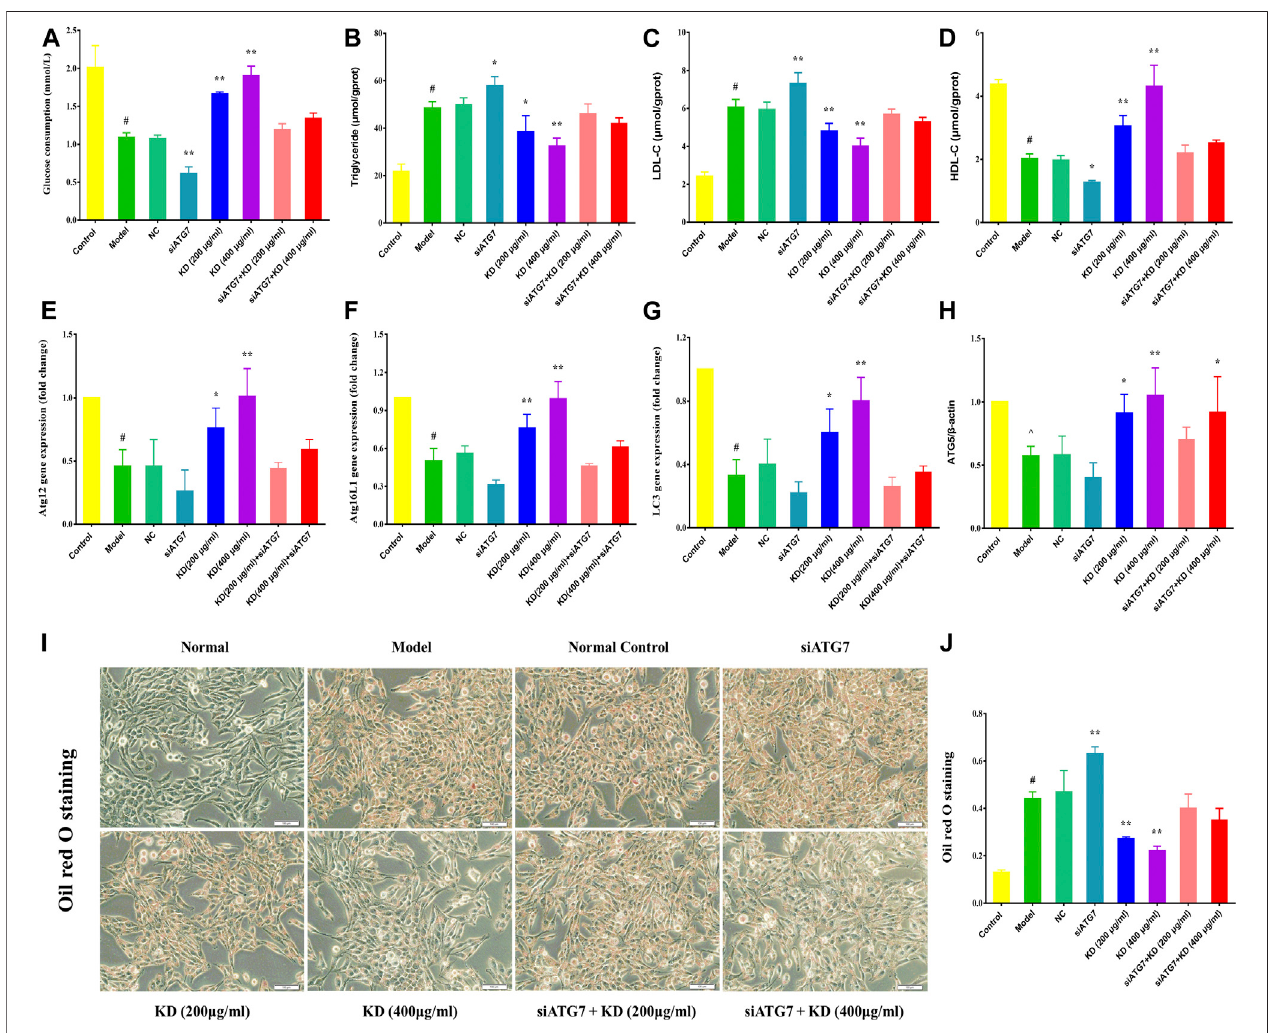
FIGURE 8 | Atg7 de fi ciency impairs the therapeutic effect of KD on insulin resistance in hepatocytes. LO2 cells were transfected with 10 nM Atg7 siRNA and a negativecontrolsiRNA. After48 h,0.25 mM oleicacidwasaddedtoLO2 cellsfor24 hand thenKDtreatmentwasperformed for24 h. (A) Theglucose consumption of hepatocytes; (B – D) Theintercellulartriglyceride,LDL-CandHDL-Ccontentsofoleicacid-inducedhepatocytes; (E) TheexpressionofAtg12gene; (F) Theexpressionof Atg16L1 gene; (G) The expression of LC3 gene; (I,J) The oil red O staining of oleic acid-induced hepatocytes; (O) Western blot analysis for Atg5 (H) , Atg7 (K) , Atg12 (L) , Atg16L1 (M) and LC3- Ⅱ / Ⅰ (N) ; (P,Q) The autophagy fl ux of hepatocytes. Data were presented as mean ± SD ( n (cid:2) 3 in each group). # P < 0.01 compared with the control group, * P < 0.05, ** P < 0.01 compared with the model